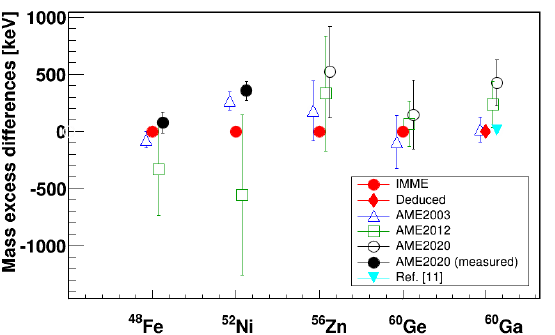
Figure 2. Mass excesses of 48 Fe, 52 Ni, 56 Zn, 60 Ge and 60 Ga. The di ff erence is shown between the values we obtain (red filled circles and diamond) [2, 6] and values from the 2003, 2012 and 2020 AMEs [20– 22]. Open symbols represent values from systematics, while filled symbols are experimental values. The cyan filled triangle is the measurement from Ref. [11]. The data points belonging to each nucleus are slightly displaced to show the error bars